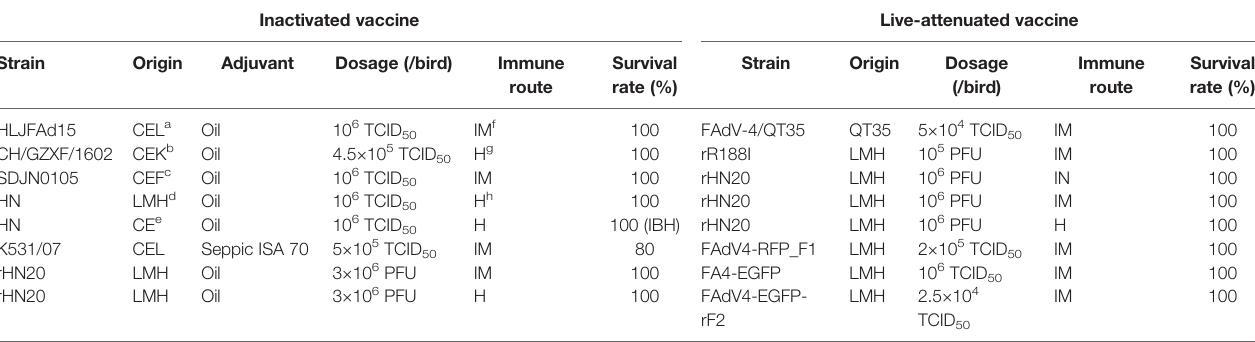
TABLE 1 | List of inactivated and live-attenuated vaccines against